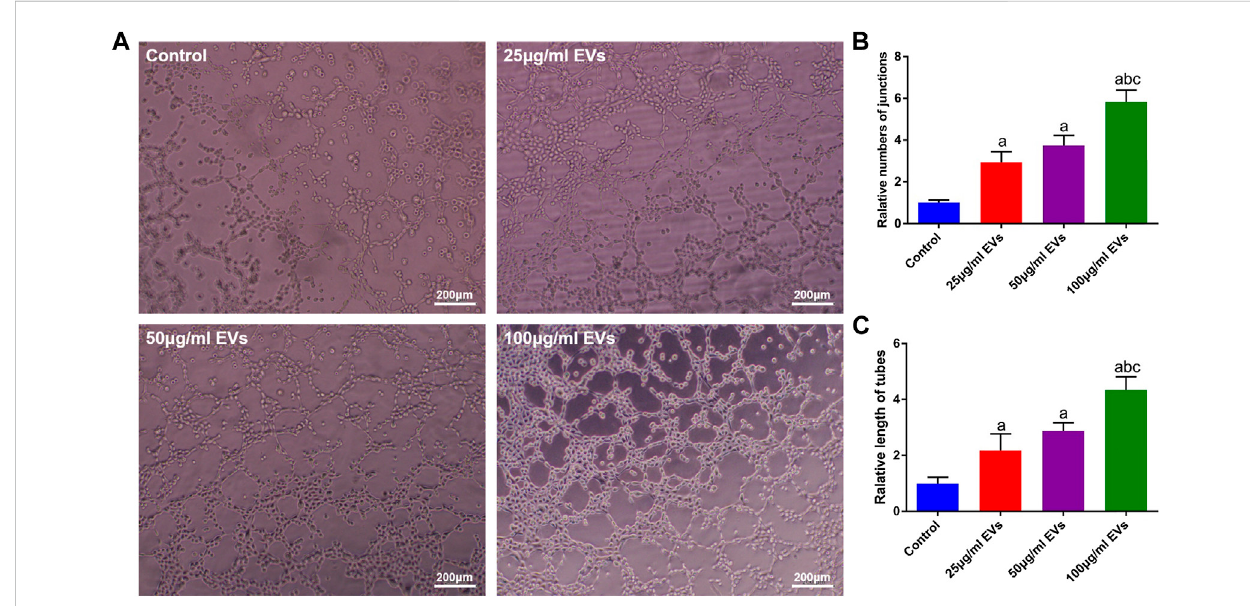
FIGURE 3 Effects of EVs on the angiogenic capacity of HUVECs (A) Image of the tube formation assay (B) Quanti fi cation analysis of tube numbers (C) Quanti fi cation analysis of tube length. a, p < 0.05 compared with the control group; b, p < 0.05 compared with the 25 μ g/ml EVs group; c, p < 0.05 compared with the 50 μ g/ml EVs